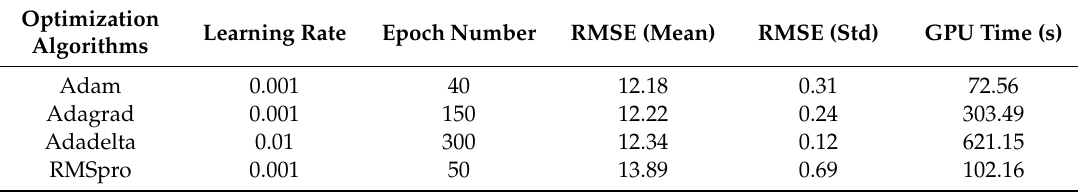
Table 6. Computational cost and